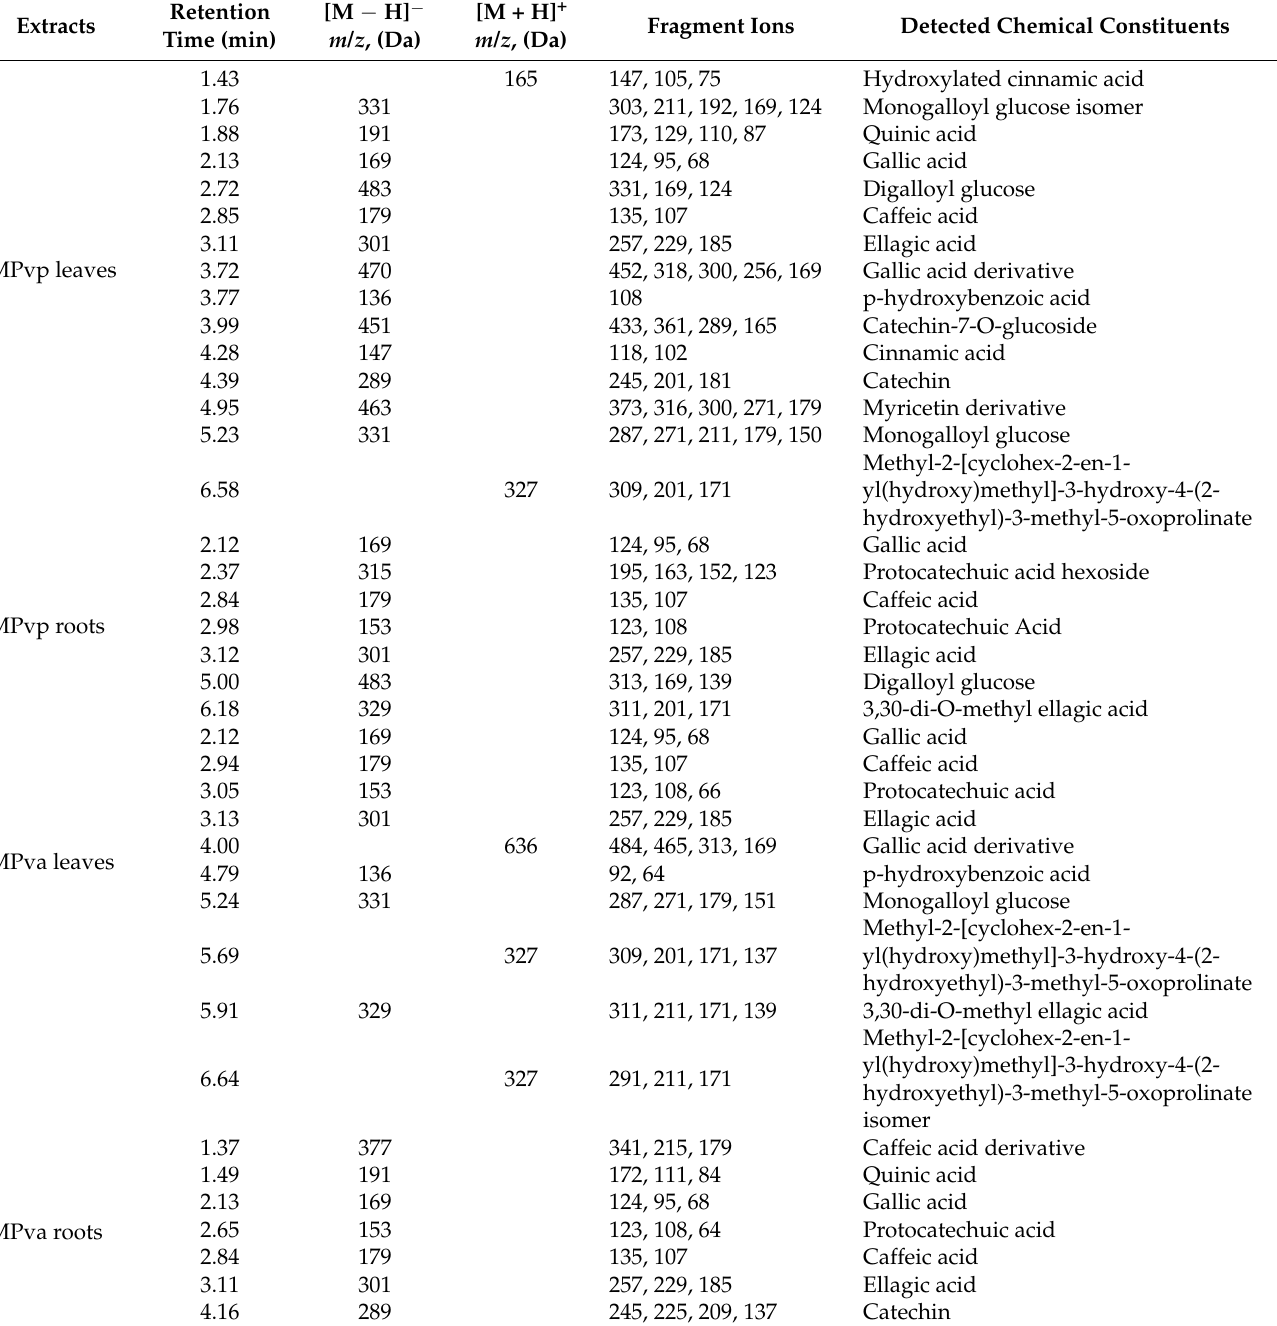
Table 1. Detection of phytochemical compounds in MP aqueous extracts using LC-MS/MS. Extracts